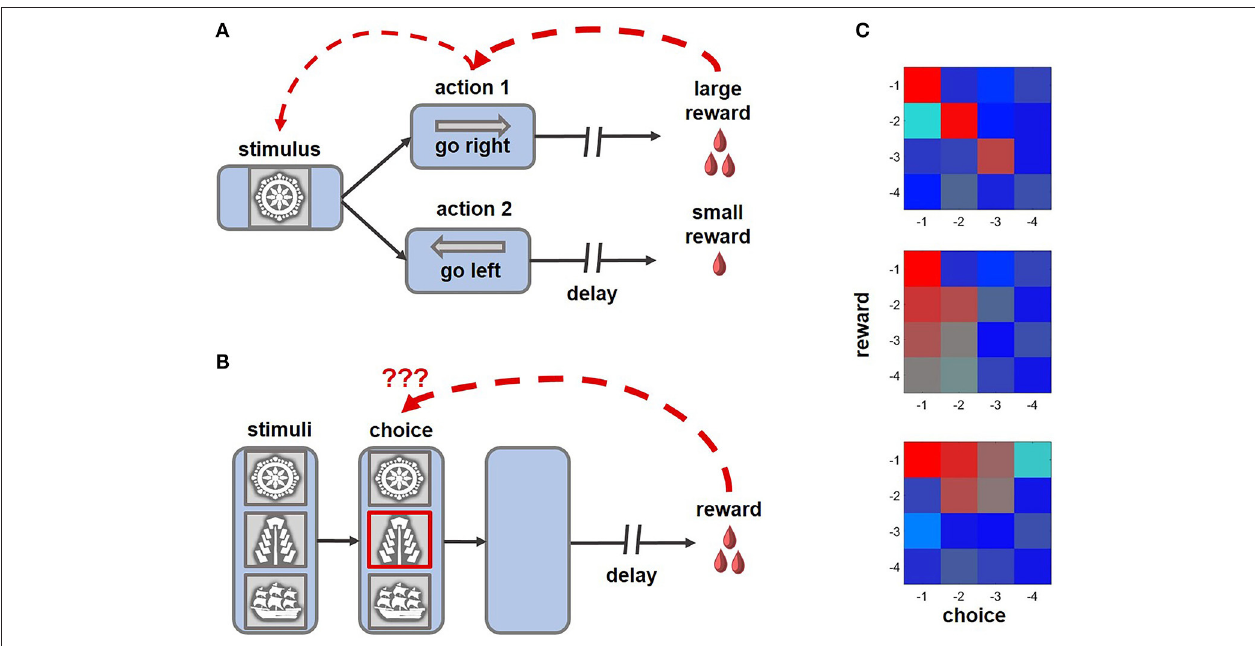
FIGURE 1 | Example tasks highlighting the challenge of credit assignment and learning strategies enabling animals to solve this problem. (A) An example of a distal reward task that can be successfully learned with eligibility traces and TD rules, where intermediate choices can acquire motivational significance and subsequently reinforce preceding decisions (ex., Pasupathy and Miller, 2005; Histed et al., 2009). (B) In this version of the task, multiple cues are present at the time of choice, only one of which is meaningful for obtaining rewards. After a brief presentation, the stimuli disappear, requiring an animal to solve a complex structural and temporal credit assignment problem (ex., Noonan et al., 2010, 2017; Niv et al., 2015; Asaad et al., 2017; while the schematic of the task captures the challenge of credit assignment, note that in some experimental variants of the behavioral paradigm stimuli disappeared before an animal revealed its choice, whereas in others the cues remained on the screen until the trial outcome was revealed). Under such conditions, learning based on eligibility traces is suboptimal, as non-specific reward signals can reinforce visual cues that did not meaningfully contribute, but occurred close, to beneficial outcomes of behavior. (C) On reward tasks, similar to the one shown in (B) , the impact of previous decisions and associated rewards on current behavior can be assessed by performing regression analyses (Jocham et al., 2016; Noonan et al., 2017 ). Here, the color of each cell in a matrix represents the magnitude of the effect of short-term choice and outcome histories, up to 4 trials into the past (red-strong influence; blue-weak influence on the current decision). Top: an animal learning based on the causal relationship between outcomes and choices (i.e., contingent learning). Middle: each choice is reinforced by a combined history of rewards (i.e., decisions are repeated if beneficial outcomes occur frequently). Bottom: the influence of recent rewards spreads to unrelated